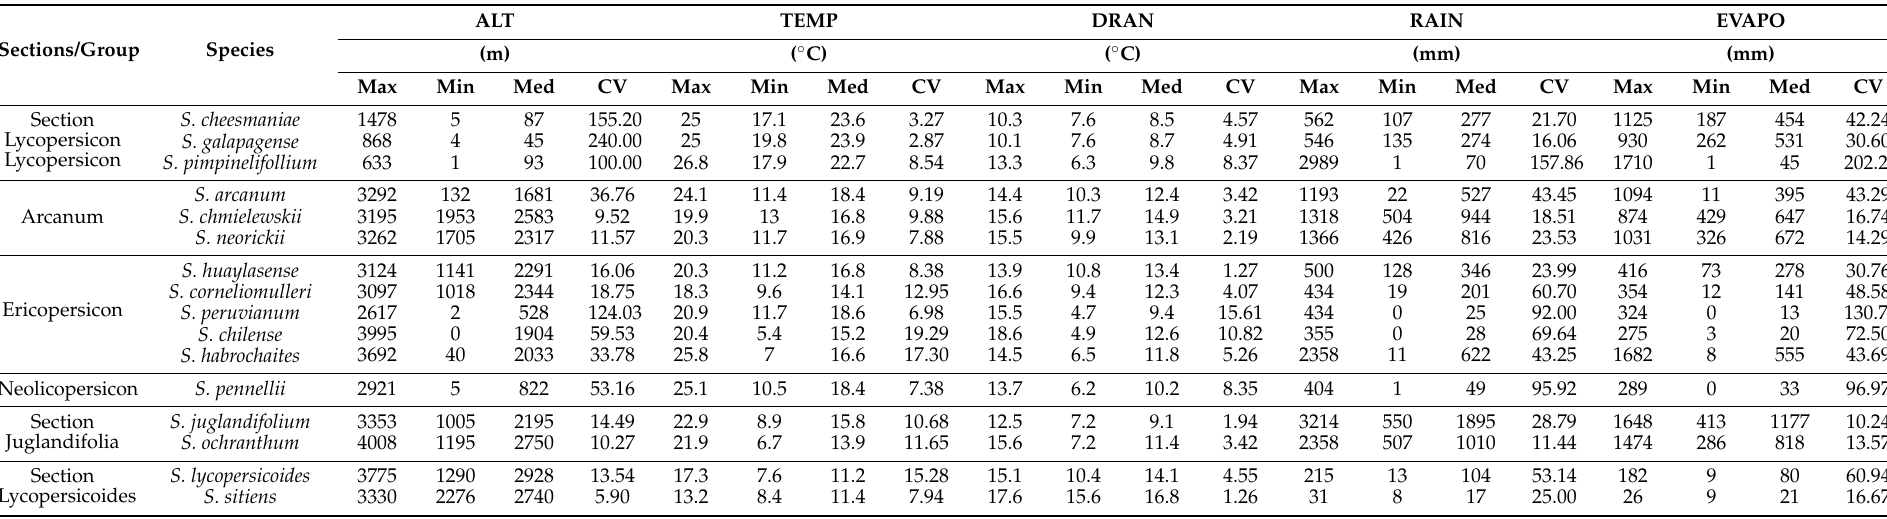
Table 2. Ecological descriptors of the wild and related species to S. lycopersicum . ALT = altitude, TEMP = annual mean temperature, DRAN = mean diurnal range, RAIN = annual precipitation, EVAPO = annual evapotranspiration. Max = maximum, Min = minimum, Med = median, and CV = coefficient of variation. Species divided according to sections and groups proposed by Peralta et al.